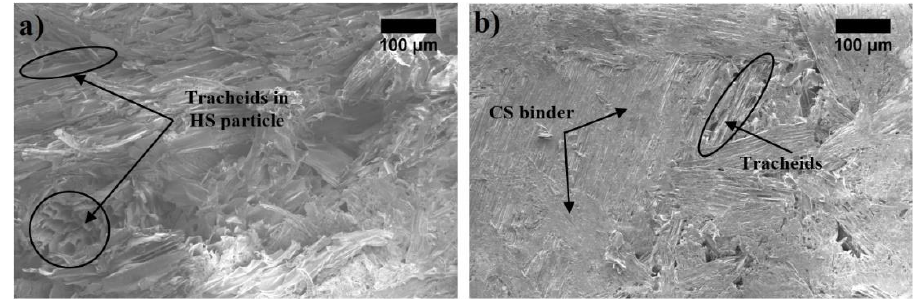
Figure 5. Microstructure of BcB (magnification ×100): ( a ) without CS binder; ( b ) with CS binder.